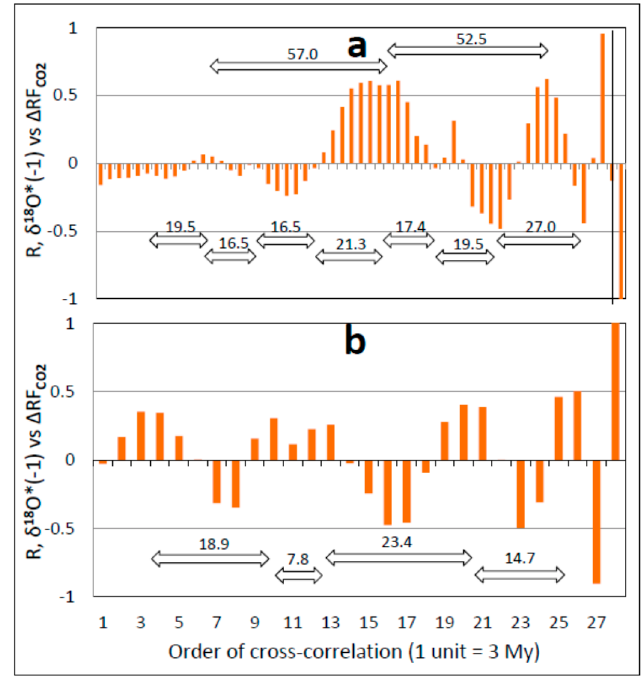
Figure 15. As in Figure 14, but for δ 18 O*( − 1) and Δ RF CO2 . ( a ) Time period from 174 to 0 Mybp. Average short and long cycle durations, 19.7 and 54.8 My respectively. ( b ) Time period from 174 to 87 Mybp. Average short cycle duration, 16.2 My. Otherwise as in the legend of Figure 12.